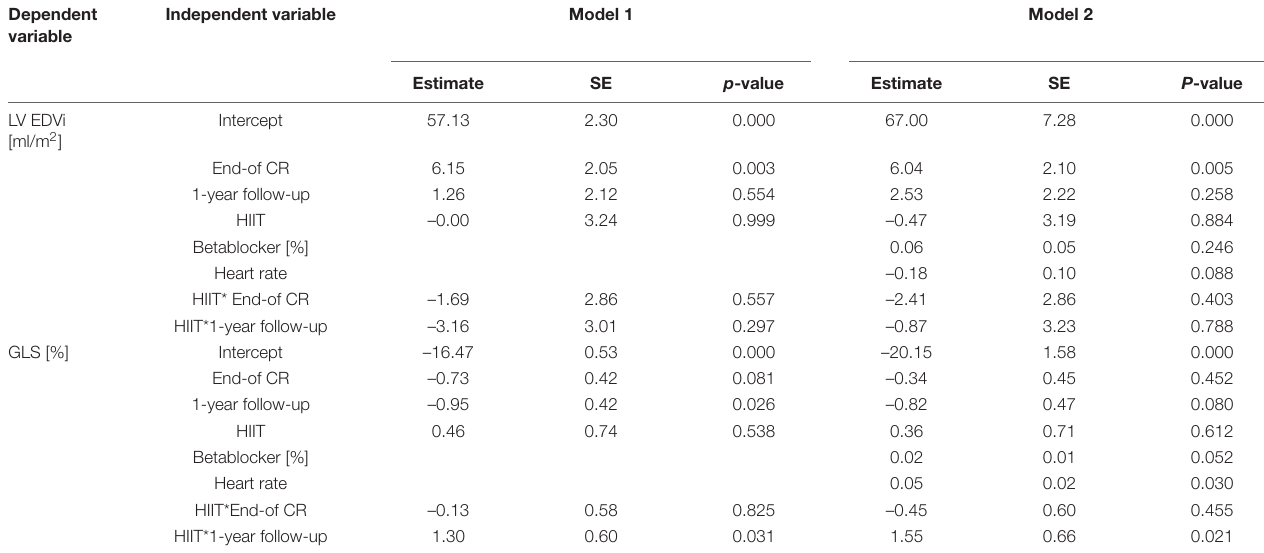
TABLE 3 | Mixed linear models for left ventricular end-diastolic volume index and global longitudinal strain with patients as random intercepts. Dependent